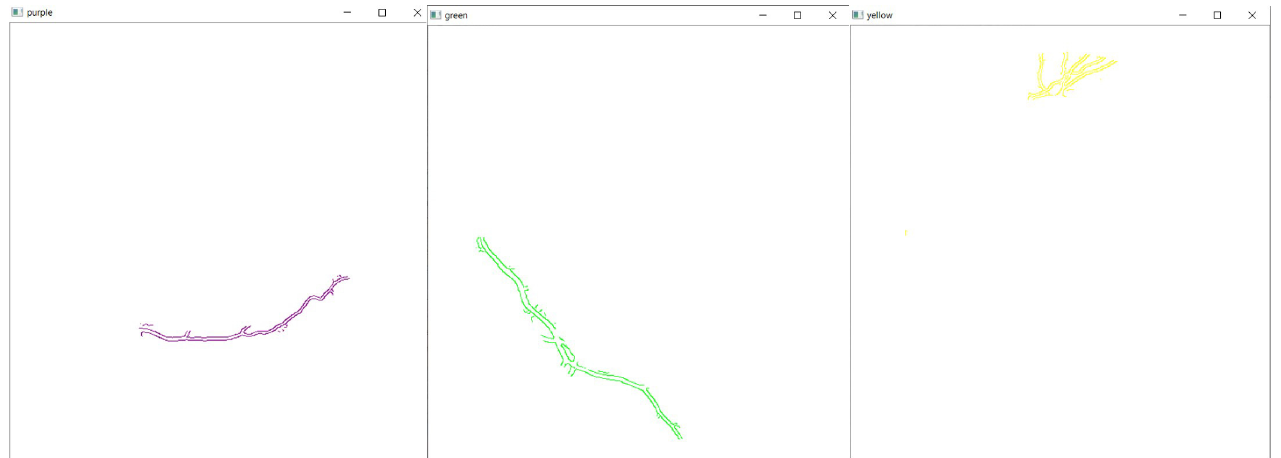
Figure 7. Segmentation of detected edges are displayed separately.